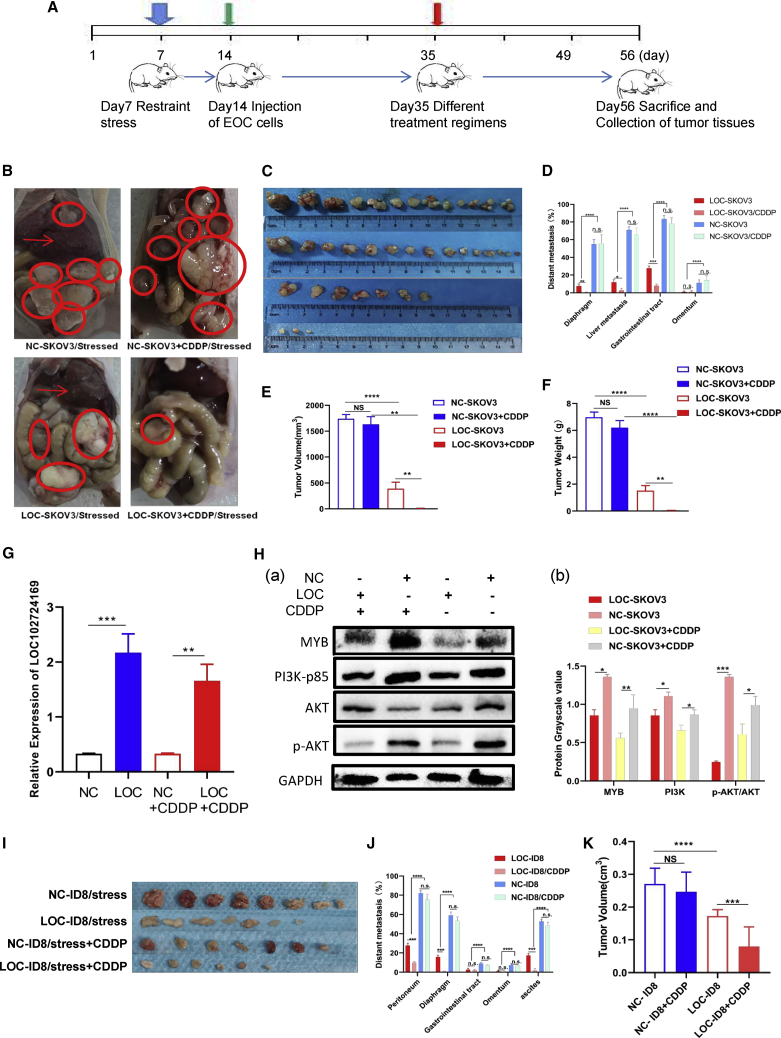
LOC102724169 overexpression increased response rate to cisplatin (CDDP) in the OCCS mice model.(A) Schematic overview of different treatment regimens on stressed mice. Blue arrow indicates all mice kept for 2 h of immobilization daily during the whole experimental cycle. Green arrow indicates that SKOV3/ID8 cells were injected intraperitoneally in nude mice with periodic immobilization in nude mice/C57BL/6. Red arrow indicates after injection of EOC cells intraperitoneally, all stressed mice were randomly divided into four groups according to different treatments: (1) empty vector viruses (NC-virs/NC-SKOV3), (2) empty vector viruses plus CDDP (NC-virs/NC-SKOV3+CDDP), (3) overexpression of LOC102724169 viruses (LOC-virs/LOC-SKOV3), (4) overexpression of LOC102724169 viruses plus CDDP (LOC-virs/LOC-SKOV3+CDDP). (B) Macroscopic tumor tissue and metastases lesions of four groups are presented, respectively. Red circles mark tumor tissues; red arrows indicate liver metastasis. (C) The tumor tissues of those groups were presented. From top to bottom are NC-SKOV3, NC-SKOV3+CDDP, LOC-SKOV3, and LOC-SKOV3+CDDP. (D) Histogram showed different metastases lesions of four groups. (E) Quantification of tumor volume in four groups. (F) Quantification of tumor weight in four groups. (G) Expression of LOC102724169 was validated in mice tumor tissue in different groups. (Ha) Western blot analysis of MYB and other related molecule expressions in different groups were validated. (Hb) Histogram represents the quantification of bands. (I) NC-ID8/ LOC-ID8 cells were intraperitoneally injected into C57BL/6 mice. The tumor tissues of NC/LOC-ID8 and those treated with cisplatin groups are presented. (J) Histogram shows different metastasis lesions of four groups in C57BL/6 mice. (K) Quantification of tumor volume in four groups. ∗p < 0.05, ∗∗p < 0.01, ∗∗∗p < 0.001, ∗∗∗∗p < 0.0001. Statistical differences calculated using a two-tailed Student’s t test. Data are represented as mean ± SEM.